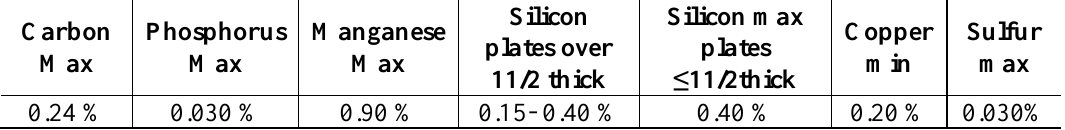
Table 1: Composition of Simi killed steel